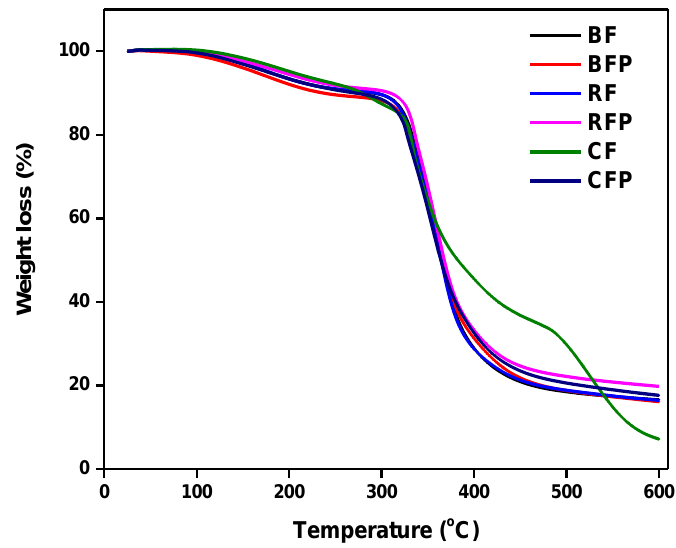
Figure 6. TGA analysis of the composites.